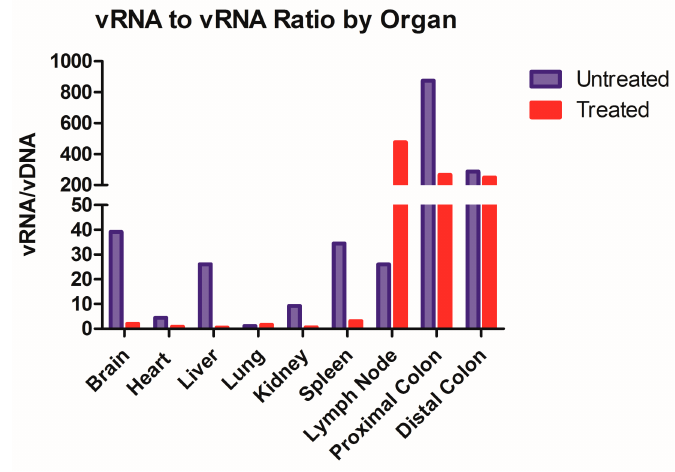
Figure 4. ARV initiation skews the vRNA/vDNA ratio towards a latent infection. The RNA viral load was divided by DNA viral load to calculate a ratio for each organ in untreated mice and treated mice, where an ARV therapeutic ratio less than the untreated signaled a skew towards HIV latency. All tissues showed this trend, with the exception of the lymph nodes, where ARV therapeutics increased the ratio. The undetermined values were set to a CT of